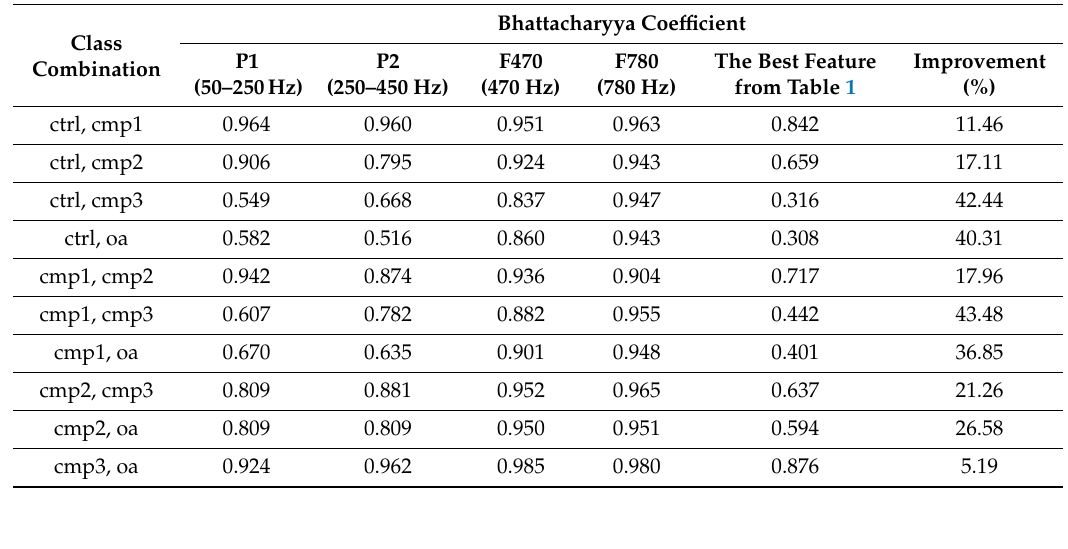
Table 3. The Bhattacharyya coe ffi cients of frequency features defined in [1] compared to present study. Table 2. Research results: the best frequency range for each feature family, for each class combination. The improvement is calculated as Corresponding Bhattacharyya coefficient values are presented in Table 1.